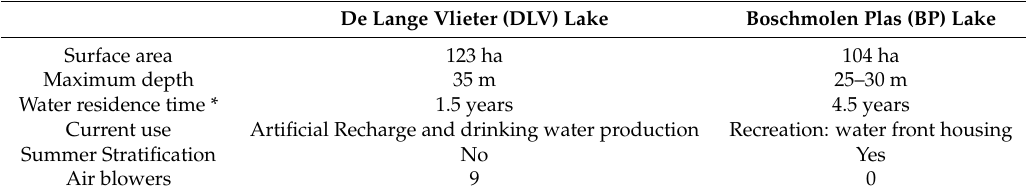
Table 1. Properties of the DLV and BP gravel pit